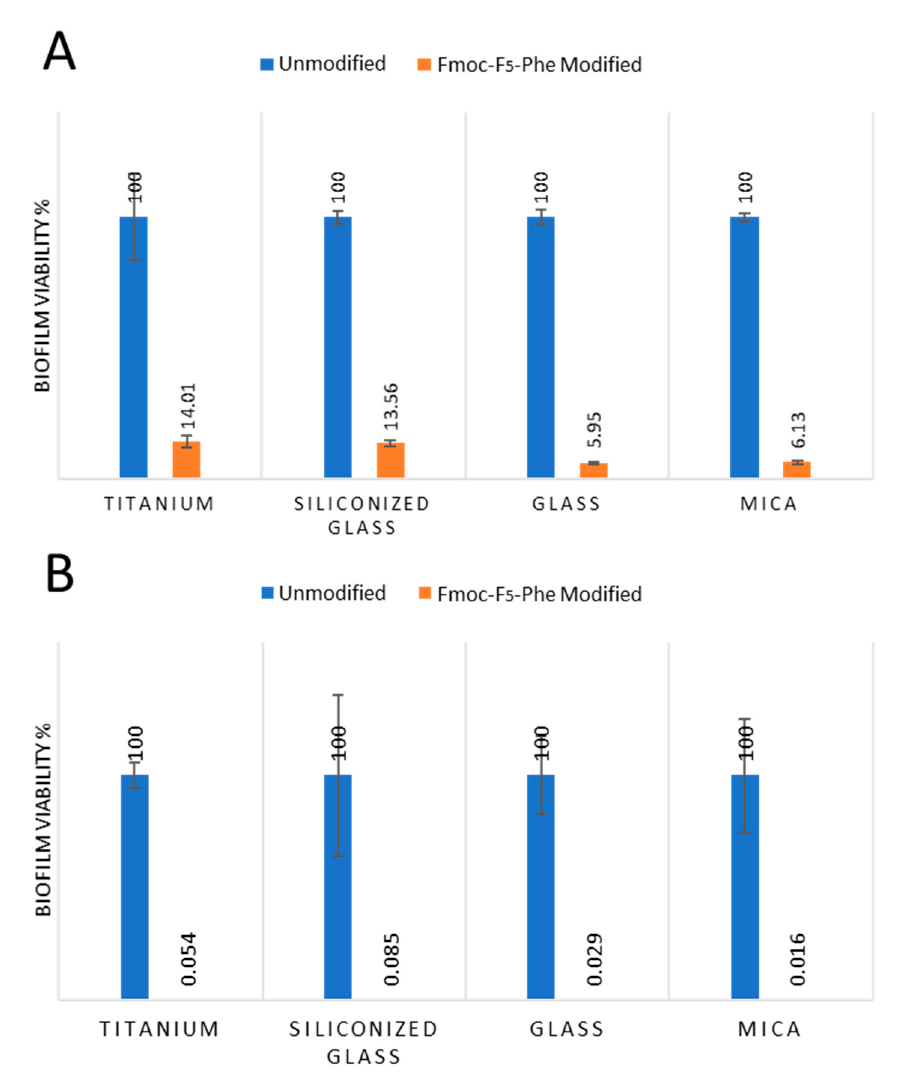
Figure 5. Quantification of biofilm viability on the modified surfaces. Relative ( A ) E. faecalis and ( B ) S. mutans biofilm viability on the four substrates modified by Fmoc-F 5 -Phe was compared to the corresponding non-modified surfaces ( n = 3). p -Test < 0.05 for all marked by **.